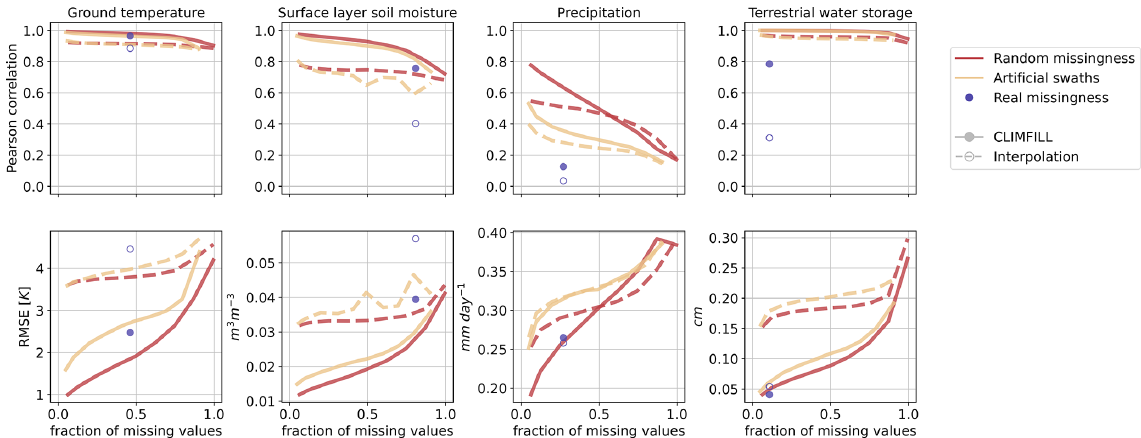
Figure 10. Median performance of gap filling with CLIMFILL and univariate interpolation on different missingness patterns and fractions of missingness expressed by two metrics: Pearson correlation and root-mean-square error (RMSE) per variable. Gap filling for random missingness and artificial swaths is executed for a range of fractions of missing values and is denoted as a line, while real missingness is only one case that is depicted as point. The metrics are calculated over each time step for all non-satellite-observable values of grid points on land, and the median of all land points is also